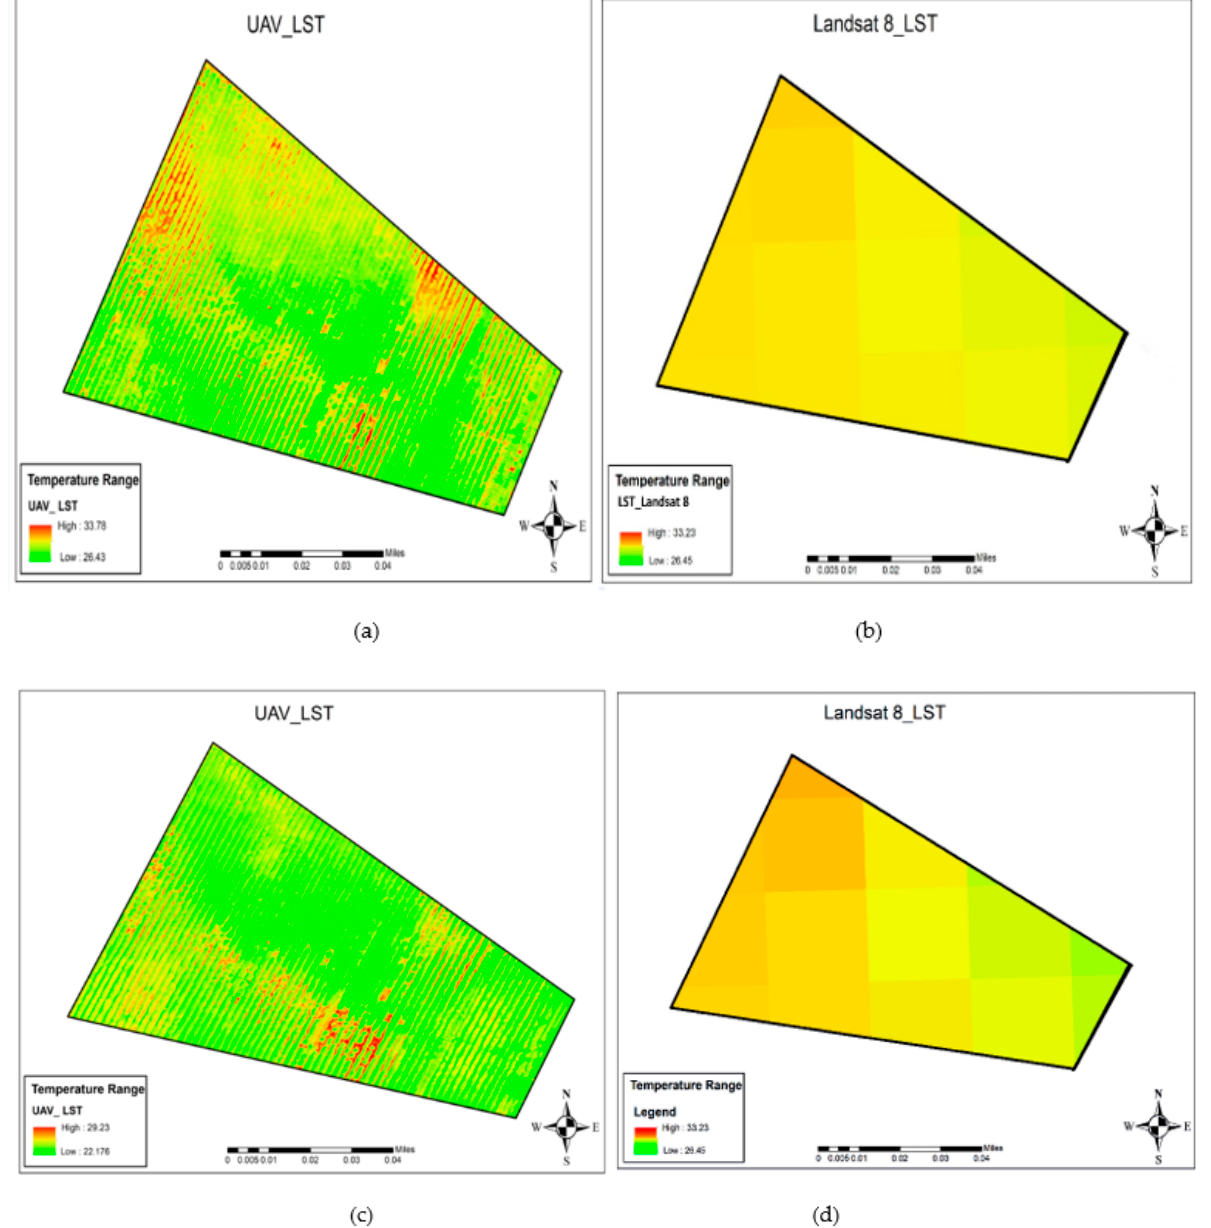
Figure 12. LST orthomosaic images between the UAV and Landsat 8, ( a , b ) DOY 230, ( c , d ) DOY 245.